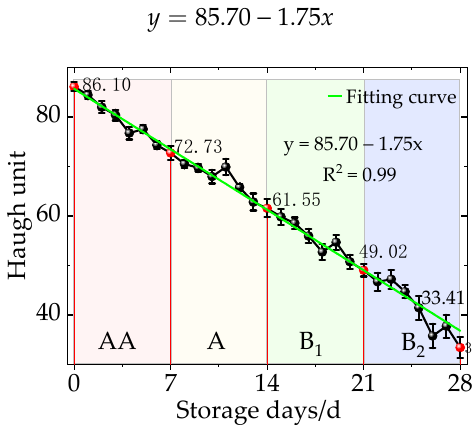
Figure 4. Haugh units of eggs versus time.